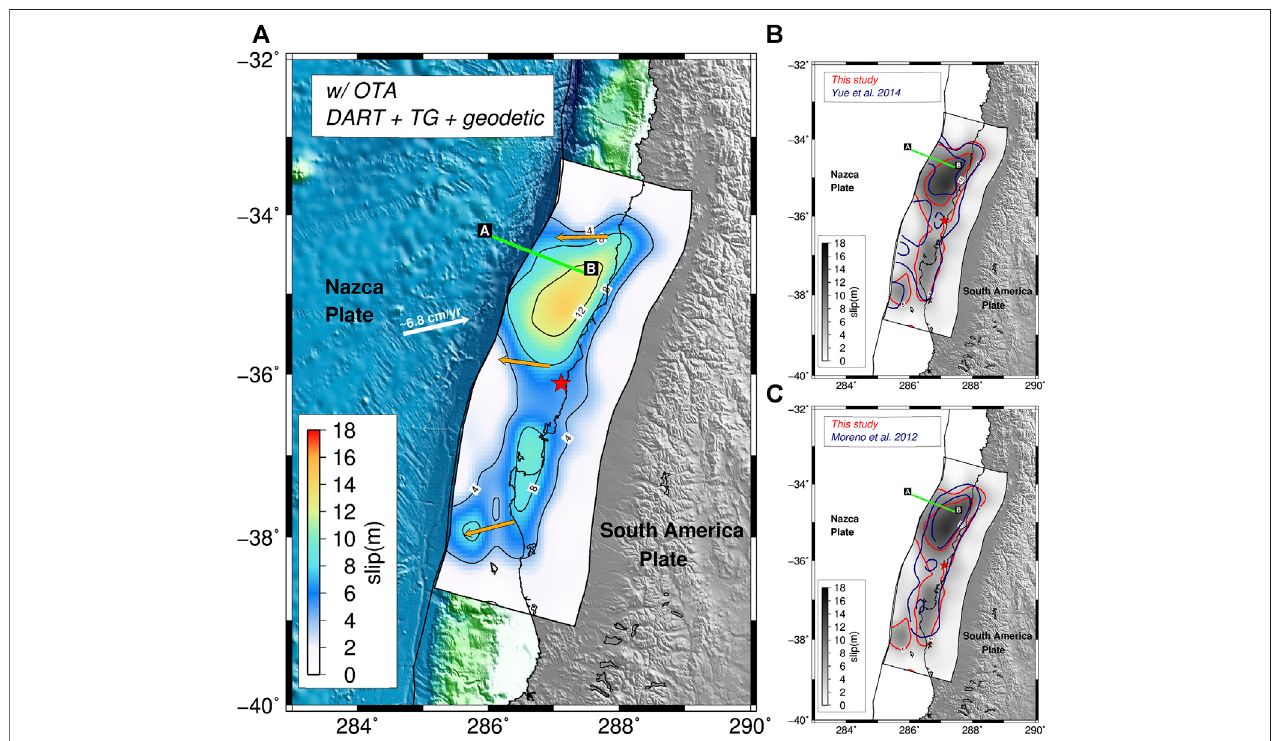
FIGURE 6 | (A) Rupture model of the 2010 Maule earthquake estimated by jointly inverting geodetic, DART, tide-gauge data, and applying OTA. Solid black lines shows the slip contour at 4 m interval; red star represents the epicenter of the Maule earthquake; orange arrows represent the average slip directions (rake); green line representstheILOCAtrack.The fi gurealsoshowsthecomparisonbetweenthe5mslipcontourlinesfromthemodel(redline)presentedinpanel (A) andthemodel(blue line) by (B) Yue et al. (2014) and (C) Moreno et al., (2012).